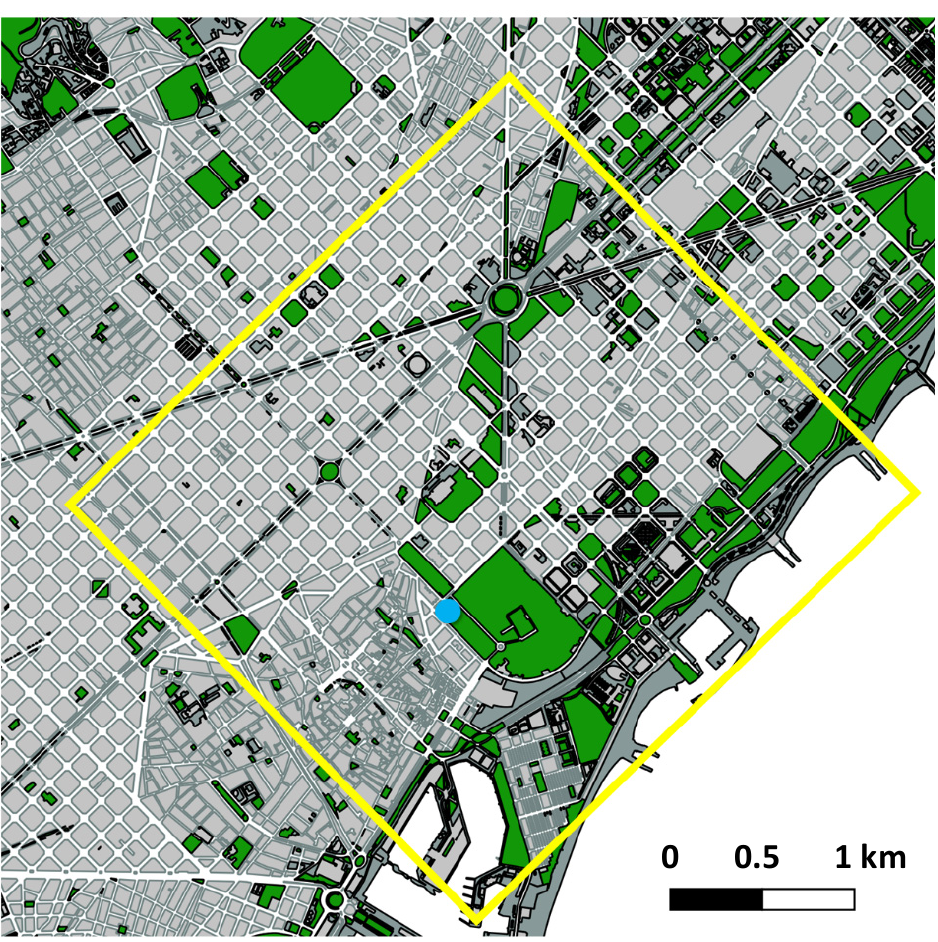
Figure 1. Map of the study area. The yellow box includes the study area (625 ha) where the transects were carried out. The blue circle indicates the location of the Museum trap. The green areas in the city are colored green.